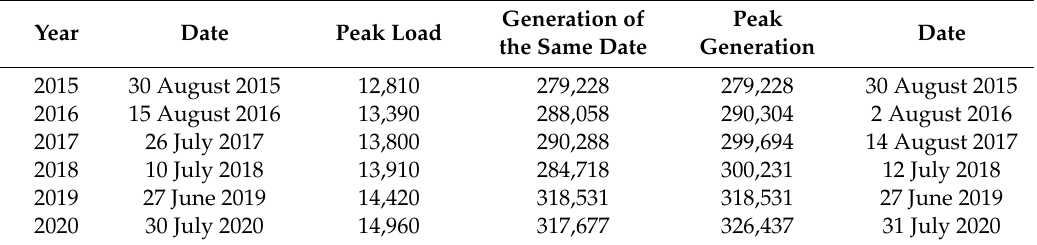
Table 5. The annual peak load and the matching generation and the annual peak generation and date. Generation of Peak Load